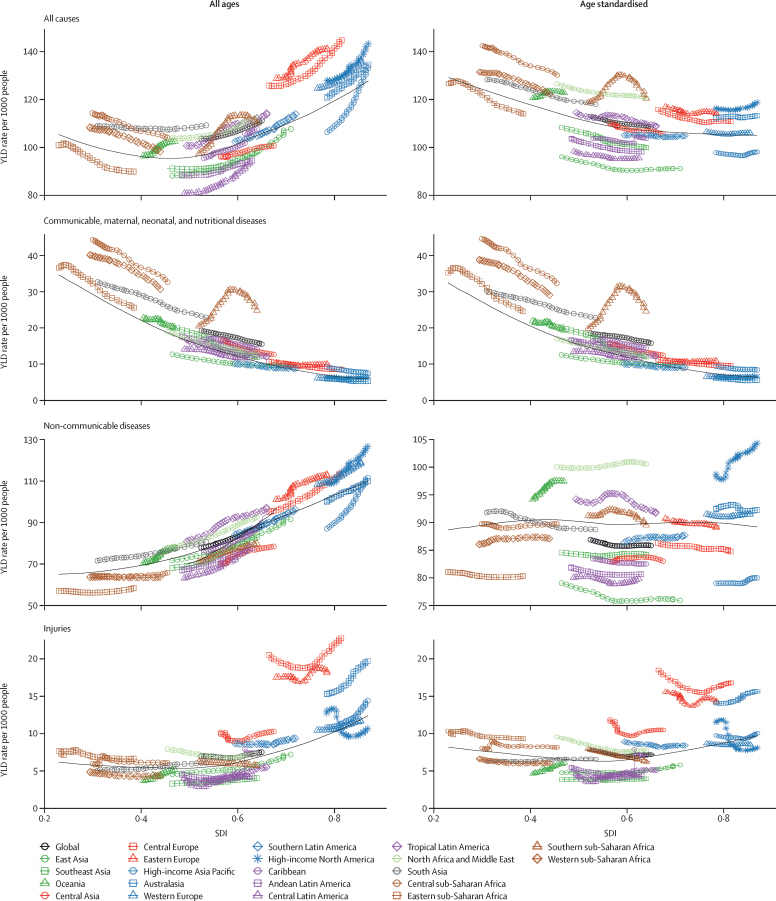
Co-evolution of all-age and age-standardised YLD rates with SDI globally and for GBD regions for Level 1 causes for both sexes combined, 1990–2017Coloured lines are global and region values for YLDs. Each point in a line represents 1 year, starting from 1990 and ending in 2017. In all regions, SDI has increased over time so progress in SDI is associated with points further to the right and later years for a given region, with a downwards gradient indicating a reduction in YLD rate. The black lines indicate the trajectories for each geography expected on the basis of SDI alone. SDI=Socio-demographic Index. YLDs=years lived with disability.